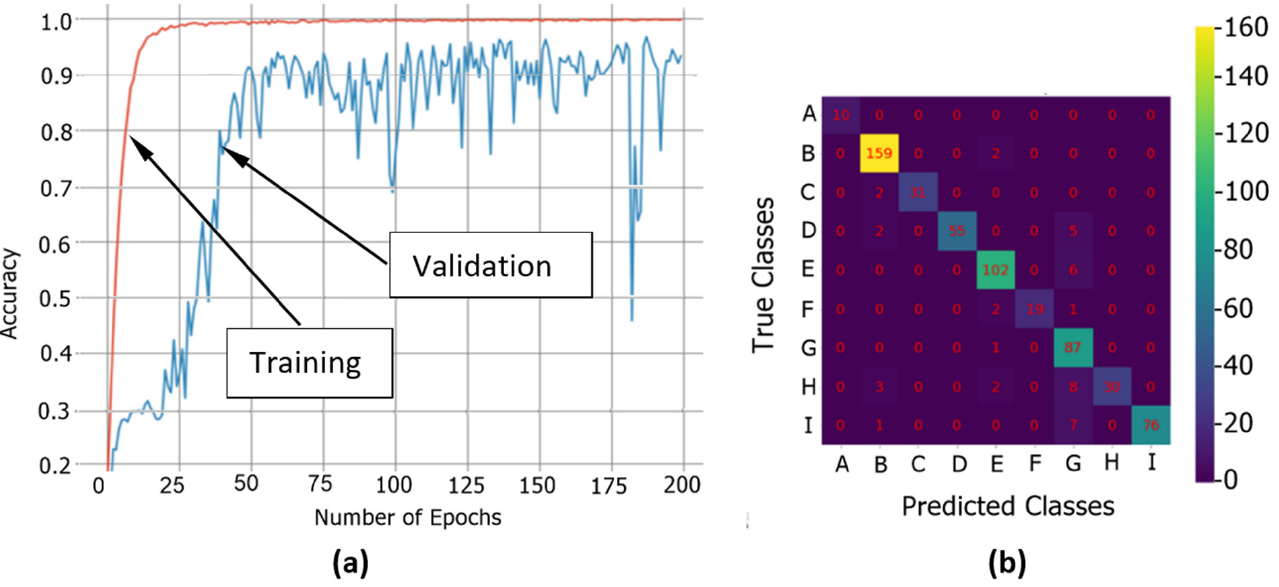
Figure 13. ( a ) Accuracy function for Training and Validation datasets for MobileNetV2 model during the second pass, 200 epochs. ( b ) Confusion matrix for the test set. Apple variety legend: (A) Blanquina, (B) Carrió, (C) Florina, (D) Fuentes, (E) Prieta, (F) Raxao, (G) Reineta Encarnada, (H) Reineta Pinta, (I) Reineta Roja del Canadá.